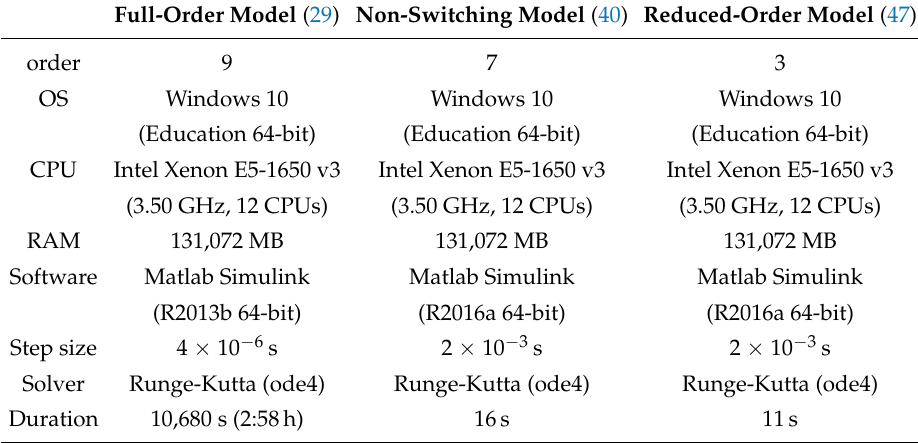
Table 2. Simulation environments and